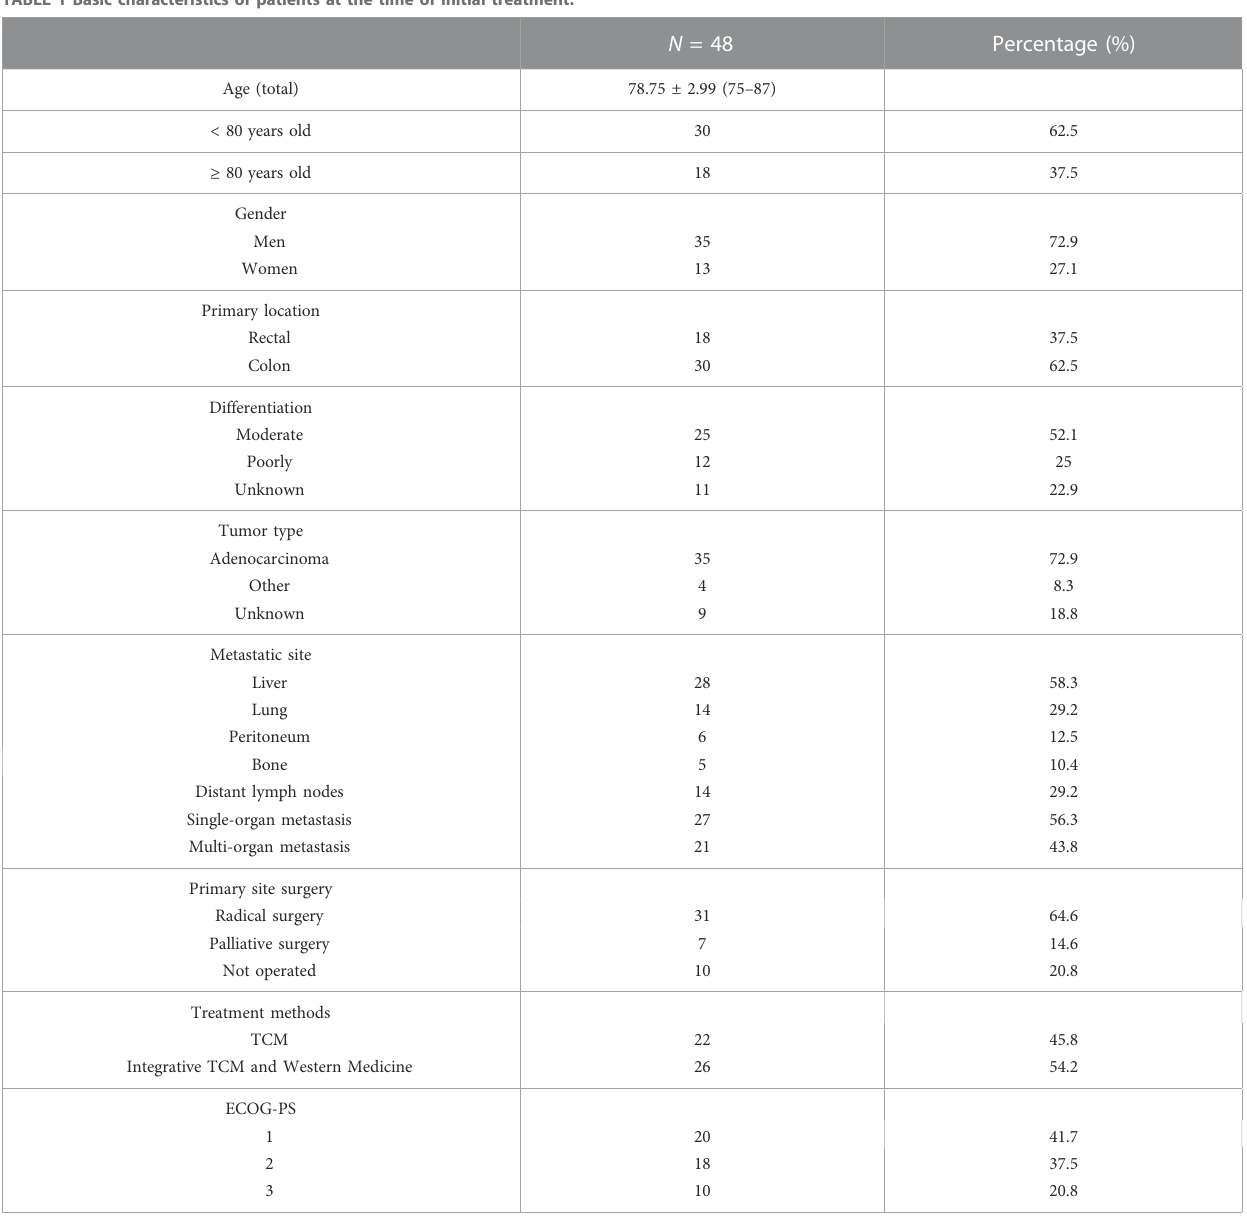
TABLE 1 Basic characteristics of patients at the time of initial